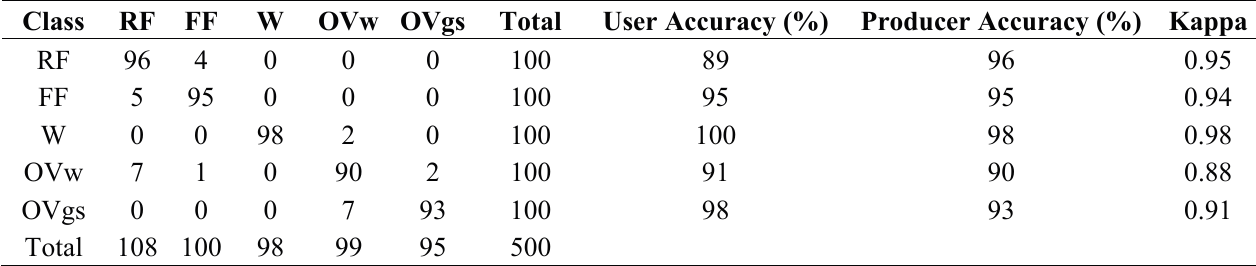
Table 3. Confusion matrix from classification with Kappa